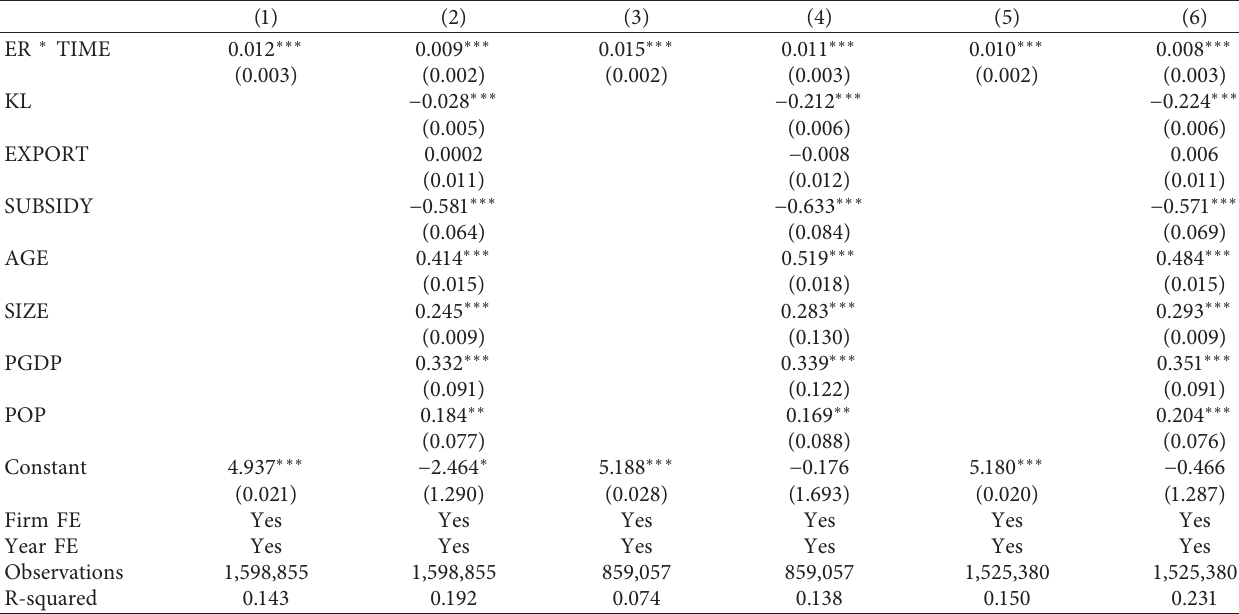
Table 6: Robustness tests